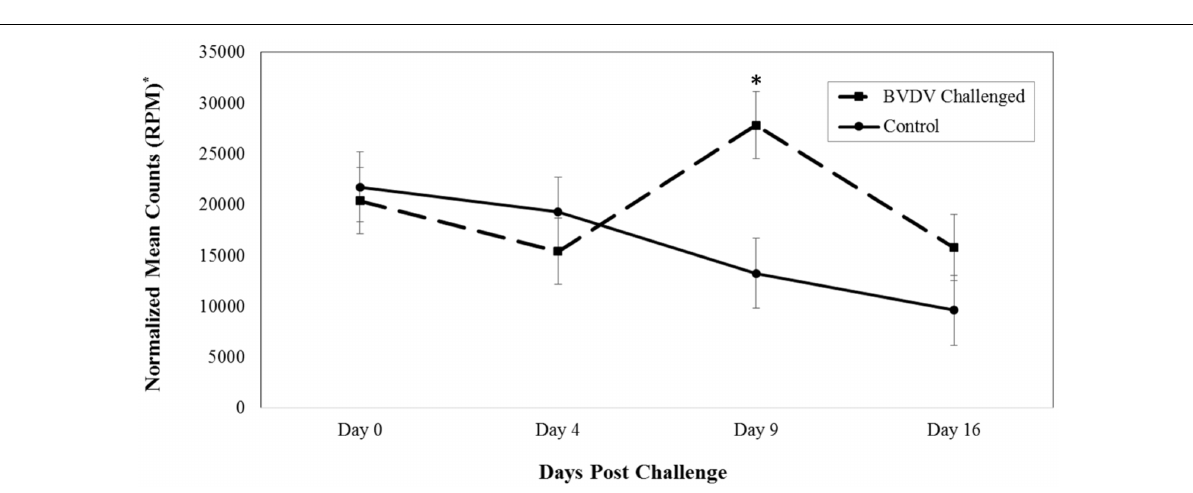
FIGURE 2 | Interaction of time and challenge status for bta-miR-151-3p ( P = 0.005). ∗ RPM stands for reads per million. Dashed line corresponds to cattle challenged with BVDV. Solid line corresponds to control animals. An asterisk above a time point represents a significant ( P < 0.05) difference in number of read counts between BVDV challenged and control animals at that particular time